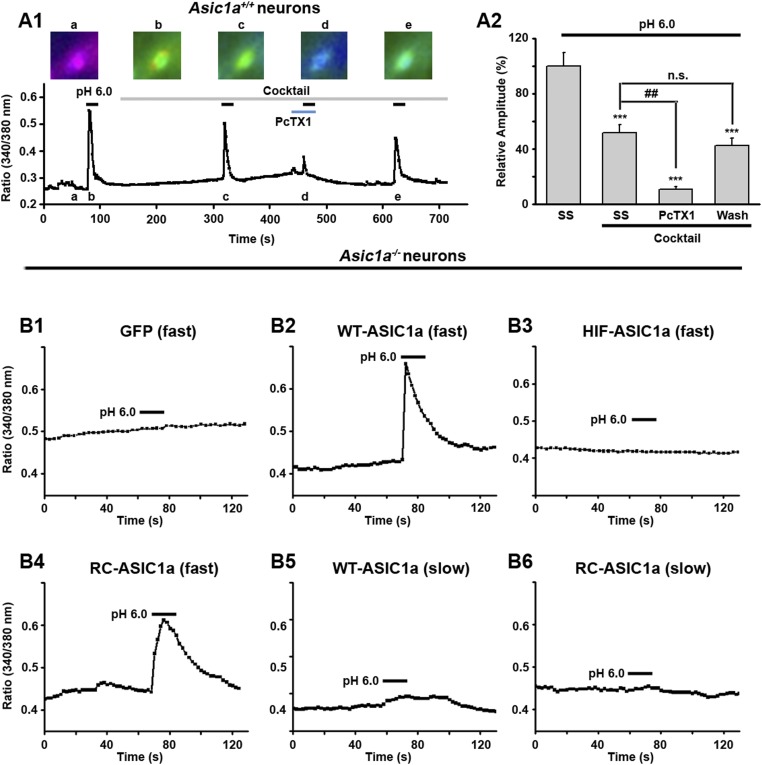
Fast perfusion is necessary for acid to induce [Ca2+]i elevation in ASIC1a-expressing neurons.(A1) Acid (pH 6.0)-induced changes in Fura-2 ratio in cultured wild type (WT) mouse cortical neurons in the absence and presence of a cocktail of inhibitors (20 μM AP5, 20 μM CNQX, 1 μM TTX, and 5 μM nimodipine) without or with 50 nM PcTX1. Representative ratio images at indicated time points are shown above the trace. Fast perfusion (∼50 µl/min) was used. (A2) Summary data of normalized ratio changes after baseline subtraction for A1 (n>10, ***p<0.001, vs SS without cocktail; ##p<0.001; n.s., no statistical significance, vs SS with cocktail). (B1–B4) pH 6.0-induced Fura-2 ratio changes in cultured cortical neurons from Asic1a−/− mice transfected with control vector (GFP, B1) and GFP-tagged WT-ASIC1a (B2), HIF-ASIC1a (B3), or RC-ASIC1a (B4) via fast perfusion (∼50 µl/min). Note: there was no change in control (B1) and HIF-ASIC1a (B3)-transfected neurons. (B5, B6) pH 6.0-induced Fura-2 ratio changes in cultured cortical neurons from Asic1a−/− mice transfected with GFP-tagged WT-ASIC1a (B5) and RC-ASIC1a (B6) via slow perfusion (∼15 µl/min). Similar results were obtained for at least 10 neurons each for B1–B6.